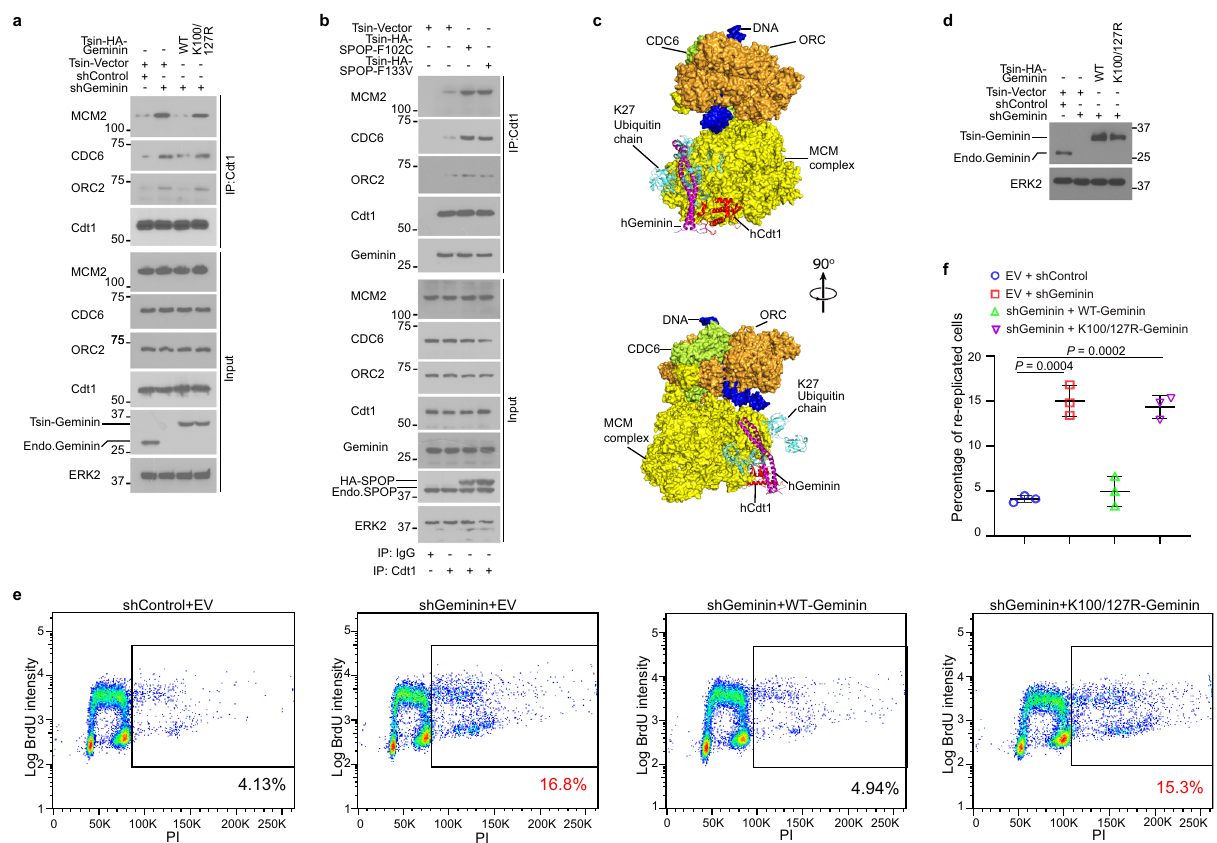
Fig. 4 SPOP-mediated poly-ubiquitination of Geminin inhibits MCM proteins binding to Cdt1. a PC-3 cells were infected with lentivirus expressing indicated shRNAs or WT or mutated Geminin and harvested for co-IP and WB analysis. b PC-3 cells were infected with lentivirus expressing empty vector or different SPOP mutants and harvested for co-IP and WB. c The structure of human Cdt1-Geminin is overlaid to that of yeast Cdt1-MCM after conformational optimization. A modeled K27-linked poly-ubiquitin chain attached to Geminin Lys127 (light blue) is incompatible with Cdt1-Geminin binding to the MCM complex. d – f PC-3 cells were infected with lentivirus expressing control shRNA or Geminin-speci fi c shRNA in combination with empty vector (EV), Geminin WT, or K100/127R mutant. Cells were pulse-labeled with 30 μ M BrdU prior to WB analysis ( d ), FACS analysis ( e ), or quanti fi cation ( f ). Data are presented as the mean ± SD of three independent experiments. Two-tailed unpaired Student ’ s t -test; *** P < 0.001. Source data are provided in this paper or Mendeley database (10.17632/8n7xt5rkhc.1). Similar results for ( a ), ( b ), and ( d ) panels were obtained in three independent